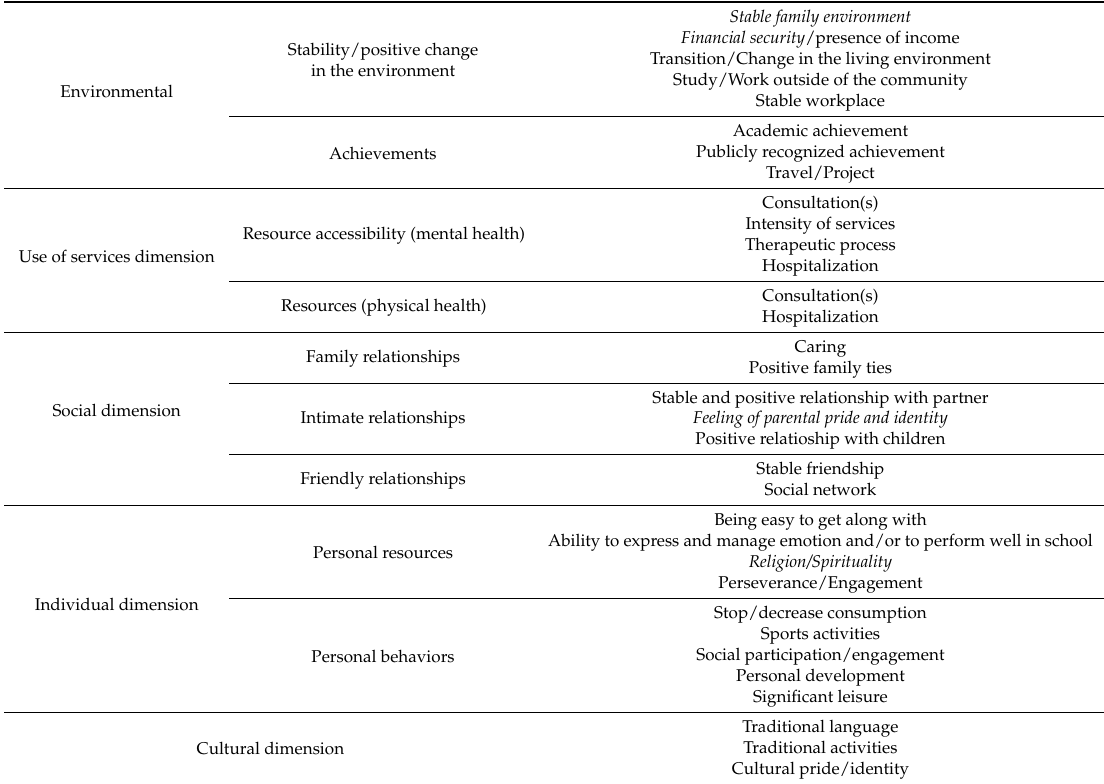
Table 1. Protective variables of the coding grid for the content